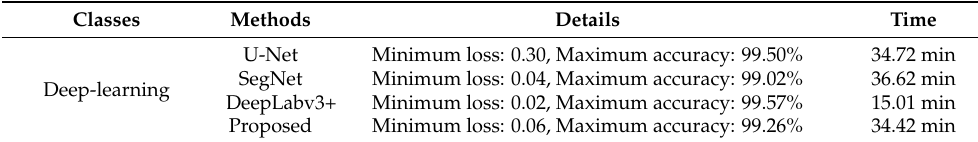
Table 4. Details of experiment 3.